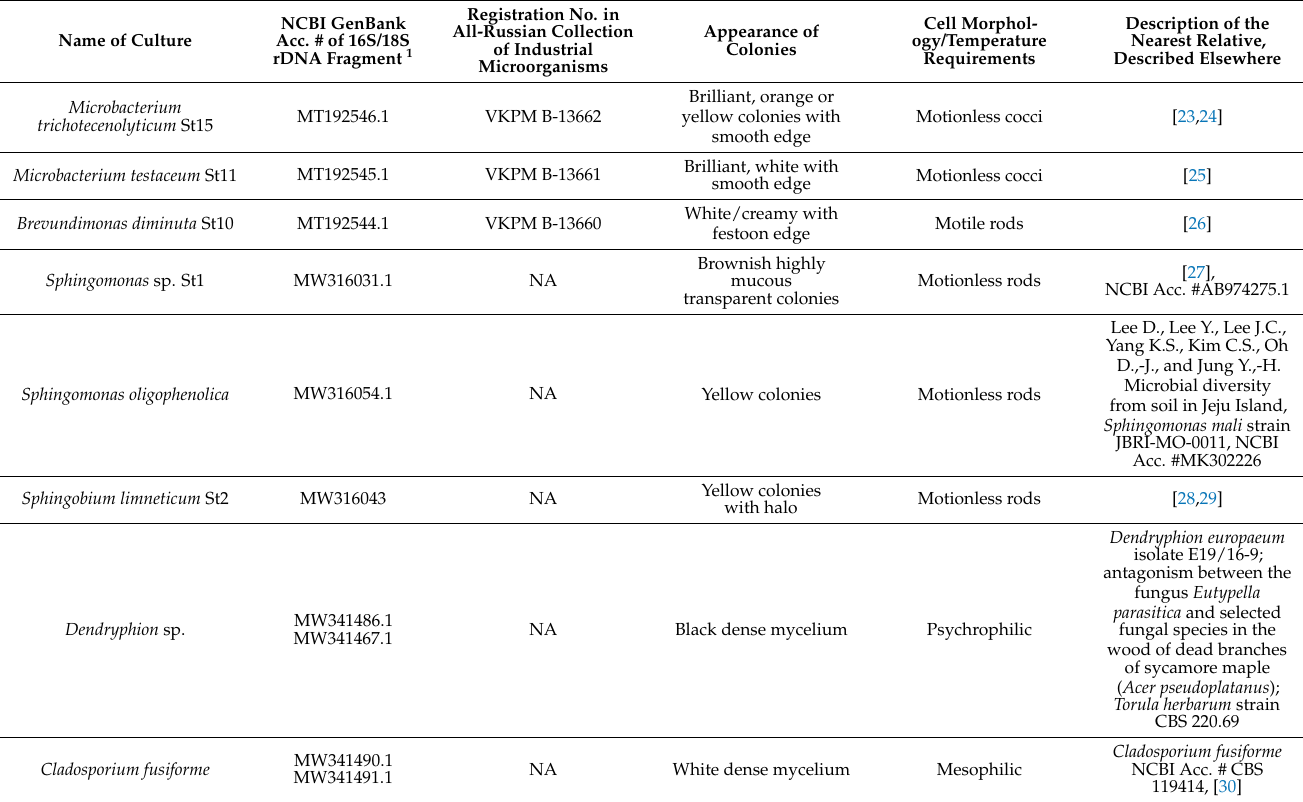
Table 2. Pure cultures of heterotrophs isolated from the water of Lake Vostok by plating on LB